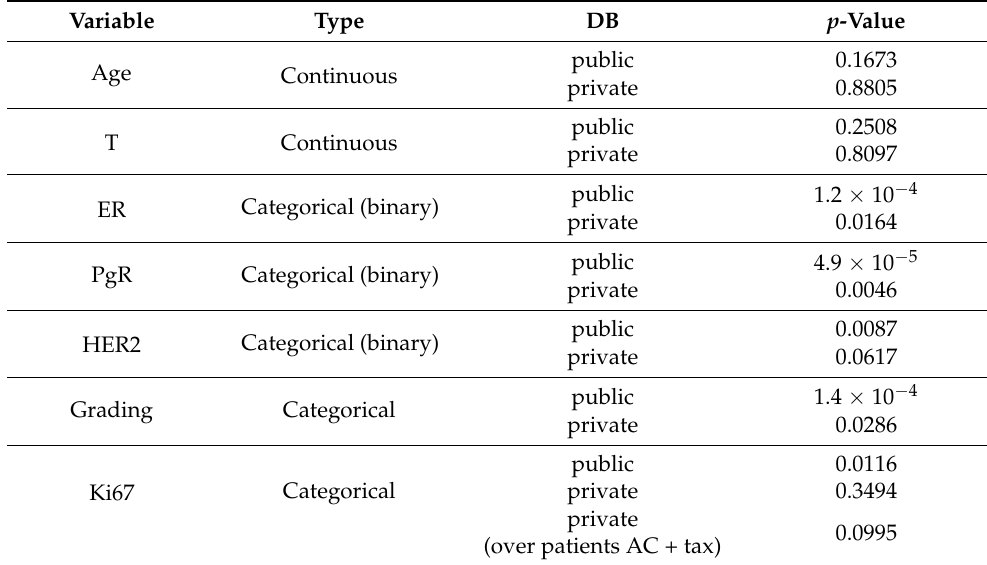
Table 2. Statistical analysis on clinical features.